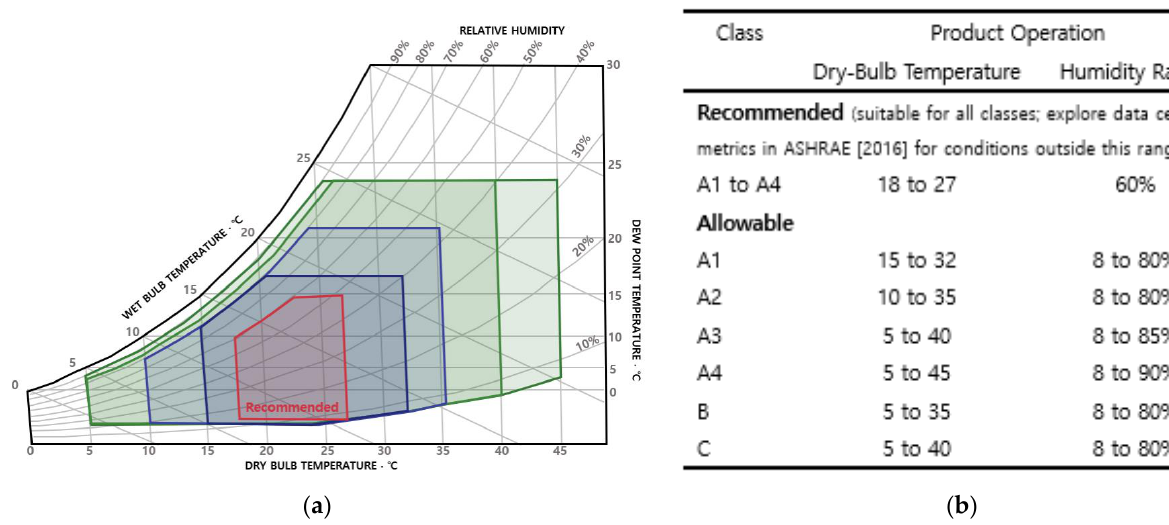
Figure 2. Indoor environmental conditions of the data center. ( a ) Class A1: Typically, a datacom room with tightly controlled environmental parameters (dew point, temperature, relative humidity) and mission critical operations; types of products typically designed for this environment are enterprise servers and storage products. ( b ) Class A2/A3/A4: Typically, an information technology space with some control of environmental parameters (dew point, temperature, relative humidity); types of products typically designed for this environment are volume servers, storage products, personal computers, and workstations.